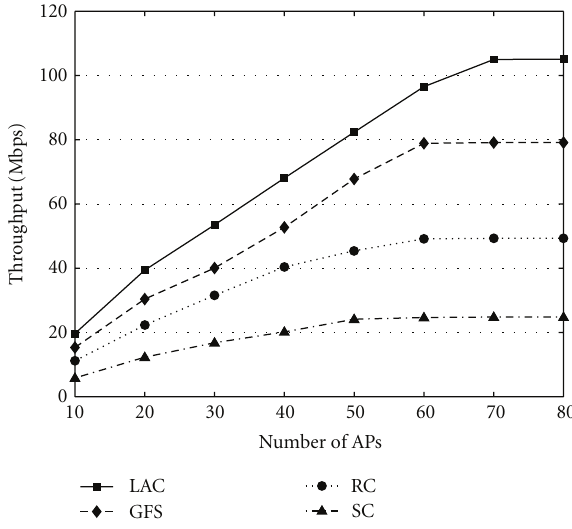
Figure 2: Total network throughput with both-directions UDP tra ffi c.